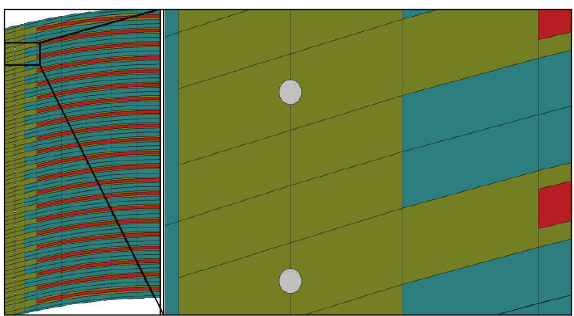
Figure 3: Half MTR fuel assembly (left) and a close-up of the cadmium wire section